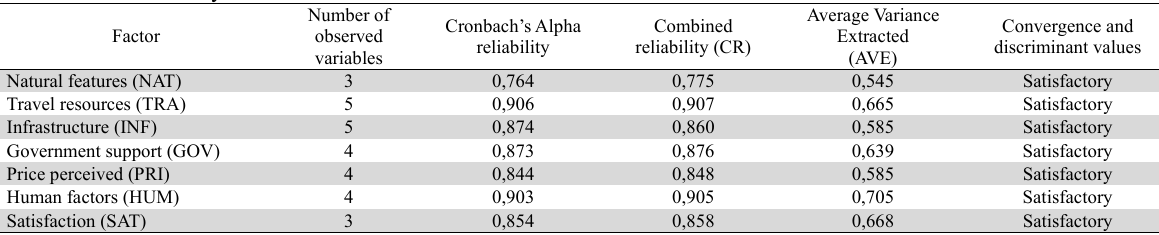
Test results of reliability of the